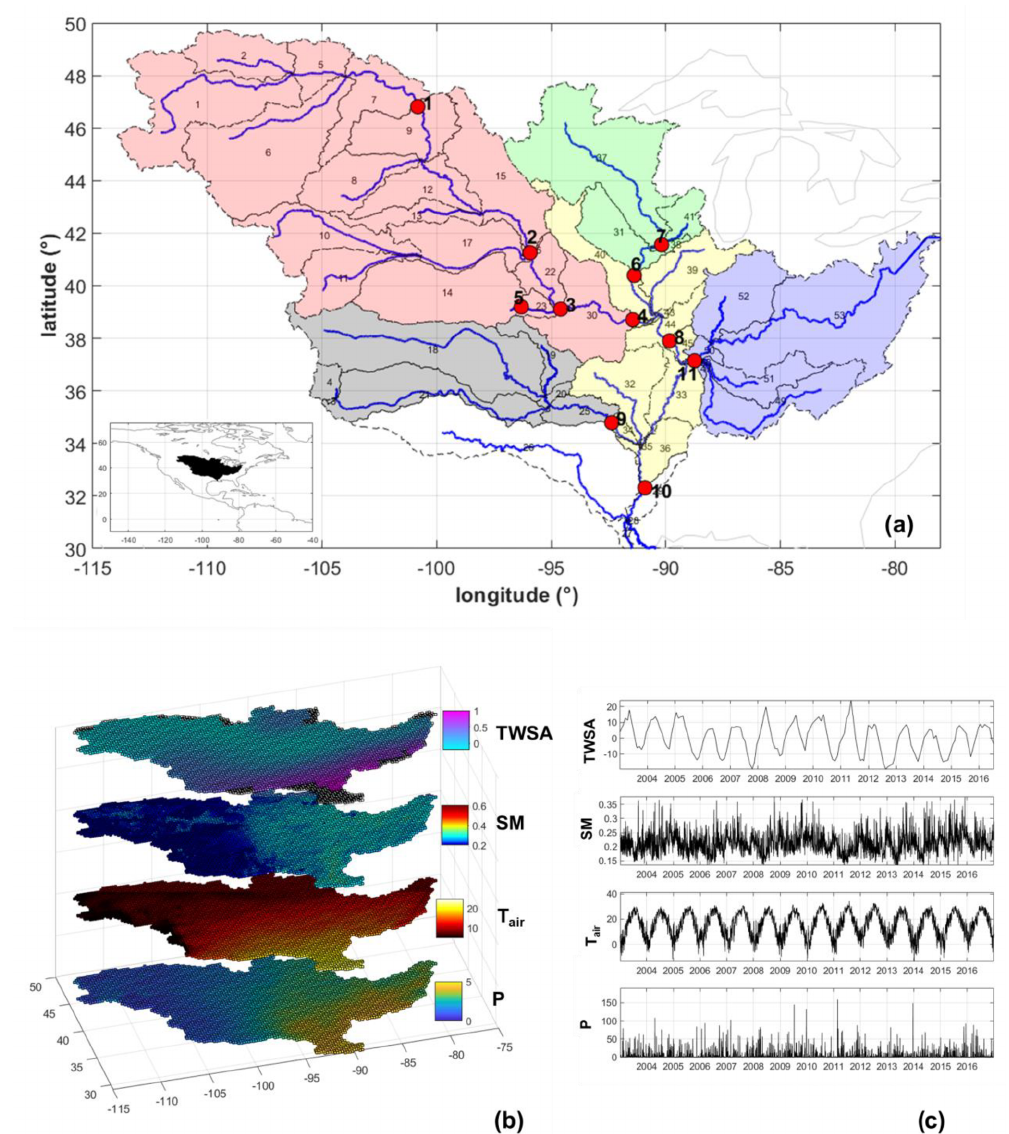
Figure 1. Mississippi River basin. Panel (a) illustrates the sub-catchment delineation. The dashed black lines and the numbers in the map identify the 53 sub-catchments (tributary and directly draining areas) in the Mississippi basin; blue lines represent the mainstem of each sub-catchment. Red dots indicate the location of the river discharge gauging stations; different colors identify different inner cross-sections (and the related contributing sub-catchments) used for the model calibration. Panel (b) shows the gridded mean daily values of the input data for the period 2003–2016. Panel (c) illustrates the input time series over a point located inside the